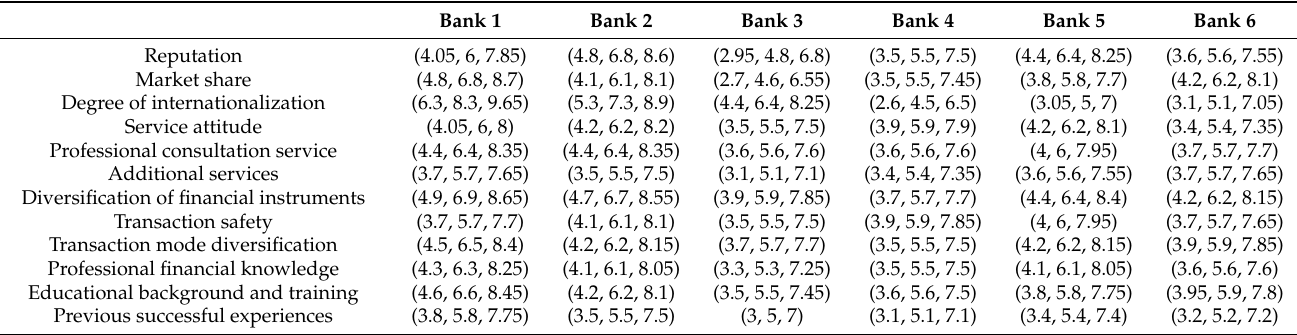
Table 4. Subjective cognition results of evaluators in linguistic